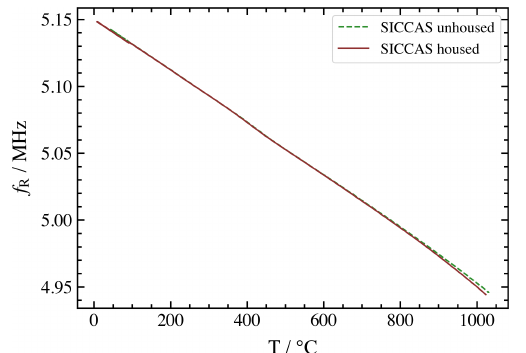
Figure 7. Phase shift of the impedance in the vicinity of the res- onance frequency. The shift from − 90 to + 90 ◦ corresponds to the series resonance; the shift from + 90 to − 90 ◦ occurs at parallel res- onance.